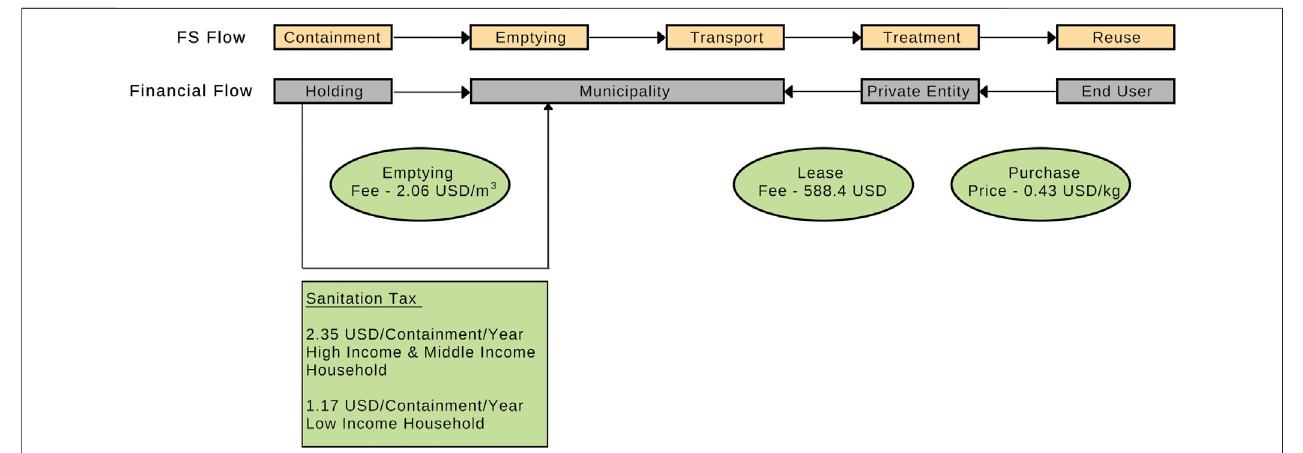
FIGURE 2 | Financial fl ows in the modi fi ed parallel tax and discharge fee model (model 6).